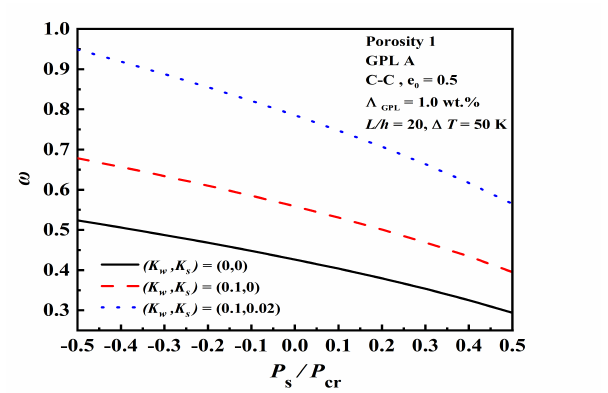
Figure 10. Effect of normalized static axial force P s / P cr on the dimensionless fundamental frequency under various foundation stiffness.